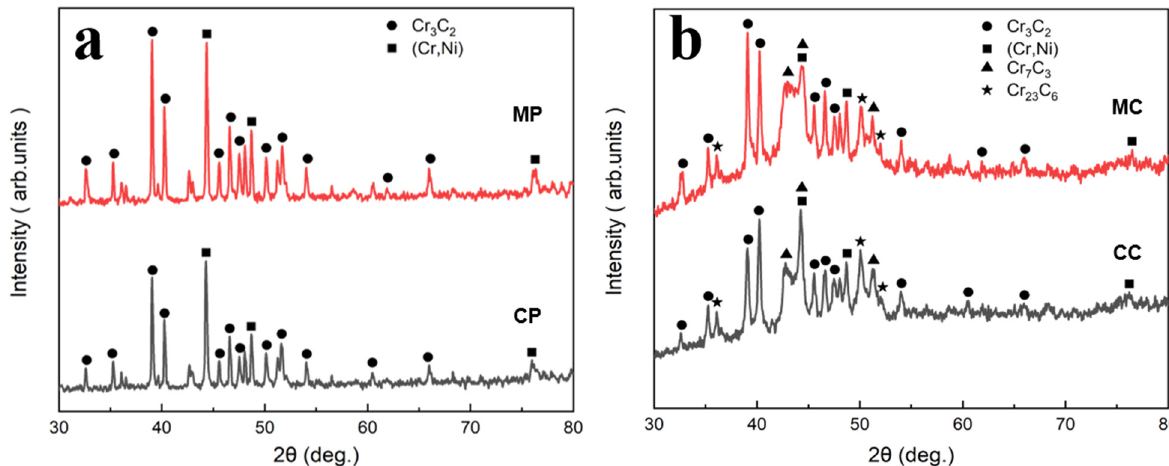
Figure 3: XRD patterns of Cr 3 C 2 – NiCr powders and coatings: ( a ) feedstock powders and ( b ) both the